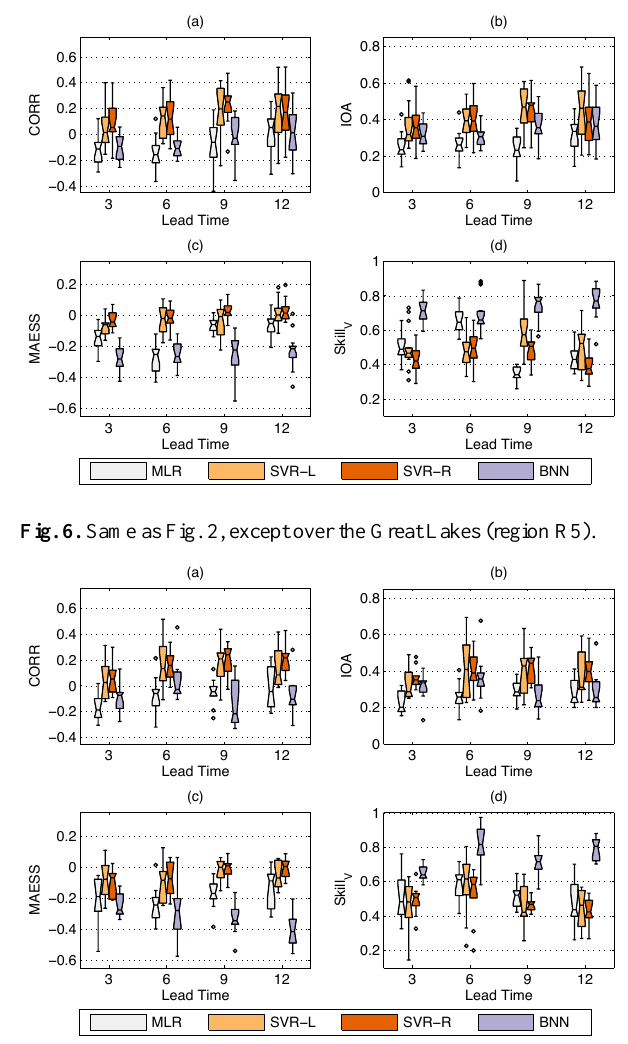
Fig. 7. Same as Fig. 2, except over the Atlantic coast (region R6). in the Prairies, the forecast correlation was around 0.3 to 0.5. For the Pacific coastal area, the correlation was always above 0.3 except at the 9-month lead. For the Cordillera, Great Lakes and Atlantic areas, the forecast skills were weaker. The spatial distribution of the difference in the correla- tion scores between the SVR-R model and the SVR-L model (Fig. 9) shows that at most stations, the nonlinear SVR method has an advantage over the linear one, though its ad- vantage decreases with increasing lead time. The advantage of the nonlinear SVR model is most prominent in the Prairies up to a lead time of 9 months. Nonlinearity is not advanta- geous over the Arctic region. A similar plot displaying the difference between the SVR- R model and the MLR (Fig. 10) shows that with only a few exceptions, the SVR-R model is clearly superior to the MLR model over all areas and at all lead times, by at least 0.2 on average in terms of the correlation